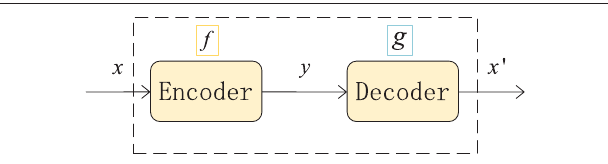
FIGURE 2 | Structure of an autoencoder. The network consists of two parts: an encoder represented by the function f and a decoder, g . The encoder compresses the input into a hidden layer representation, and the decoder reconstructs the input from the hidden layer.